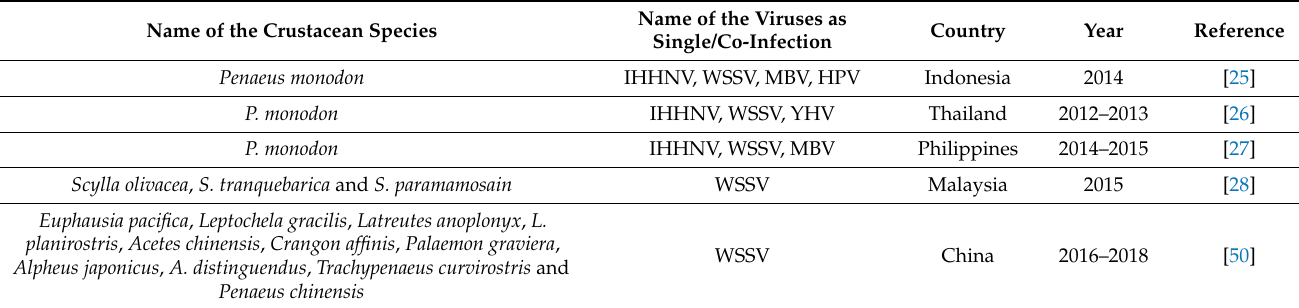
Table 5. Summary of single and co-infection of various viruses in the wild crustaceans reported from different countries. Name of the Crustacean Species